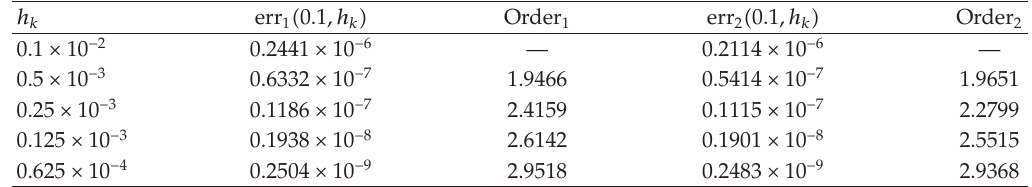
Table 1: The error and the convergence order.